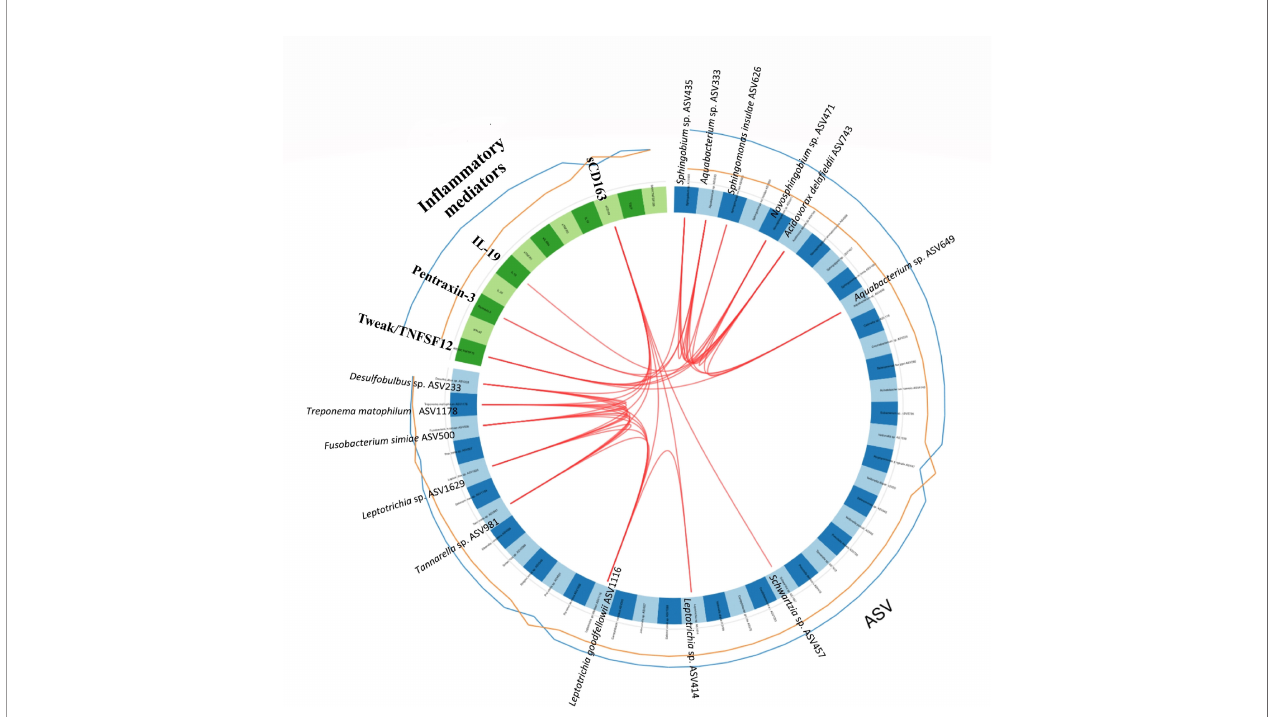
FIGURE 7 | Circos plot depicting correlations between microbiota and in fl ammatory mediators/cytokines. The panel of Amplicon Sequence Variants (ASVs) and cytokines are identi fi ed by the sparse partial least squares discriminant analysis (sPLS-DA). The fi rst and second component from the sPLS-DA model are included in the Circos plot. Blue variables represent ASVs and green variables represent in fl ammatory mediators/cytokines. The lines outside the circle represent the ASV abundance or the level of in fl ammatory mediators in samples from patients with RA (blue) and without RA (orange), respectively. Red lines inside the circle represent positive correlations between ASVs and host response mediators, at a correlation > 0.7. The lowest annotated taxonomic rank is shown for each ASV together with its ASV ID